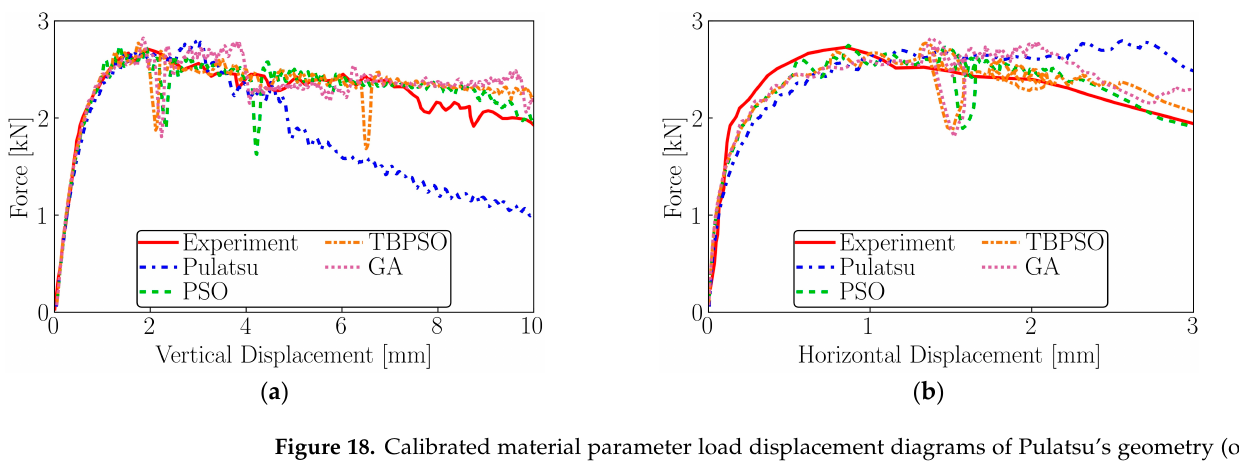
24 of 32 Figure 17. Position of calibrated material parameters of Pulatsu’s geometry (objective function 2, PSO and GA: 50 iterations; TBPSO: 20 iterations). Table 2 . Five best solution sets for objective function 2 of Pulatsu’s geometry. Calibration Process